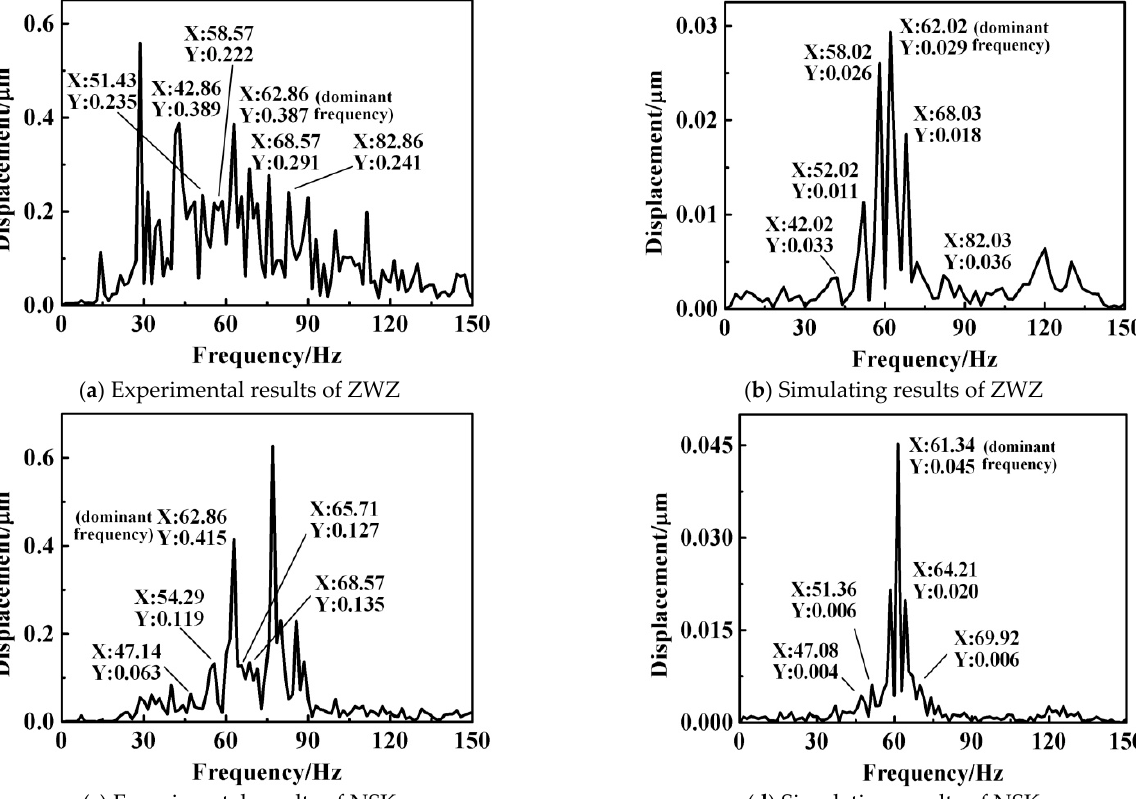
Figure 24. The displacement vibration spectrum of SRBs from manufacturers ZWZ and FAG under limiting self ‐ aligning operating condition.